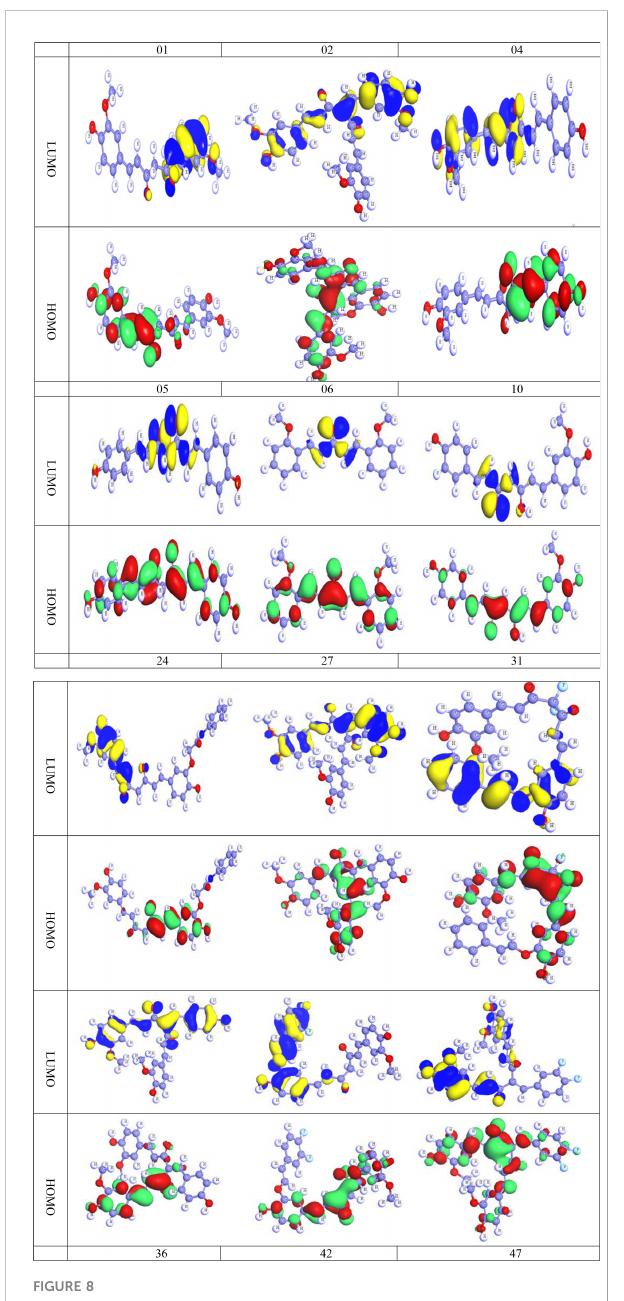
FIGURE 8 HOMO and LUMO diagram of curcumin and its derivatives.